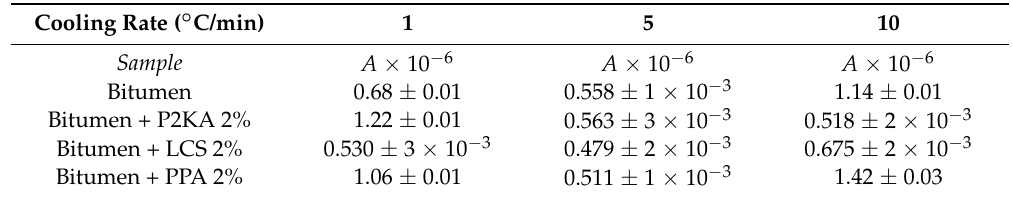
Table 3. Dependence of the “interaction strength” A on the cooling rate, calculated as a fitting parameter in Equation (1) adapted to experimental oscillatory rheological data, |G*| vs. frequency, for neat bitumen and bitumens modified with additives.